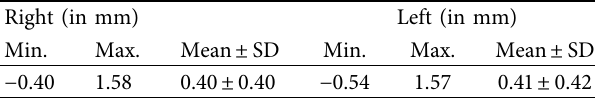
Table 2: Relative GZL of LIs. Right (in mm)